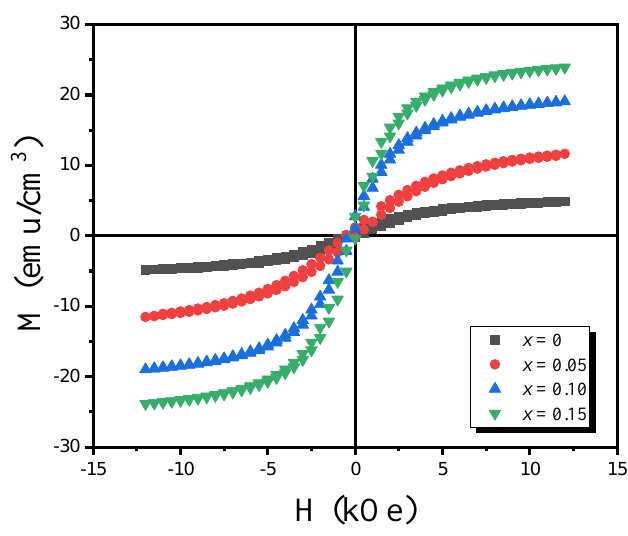
Figure 9. M - H curves of Bi 1 − x Gd x FeO 3 ( x = 0.00, 0.05, 0.10, and 0.15) films. The curves of hardness versus load penetration depth are illustrated in Figure 10a.